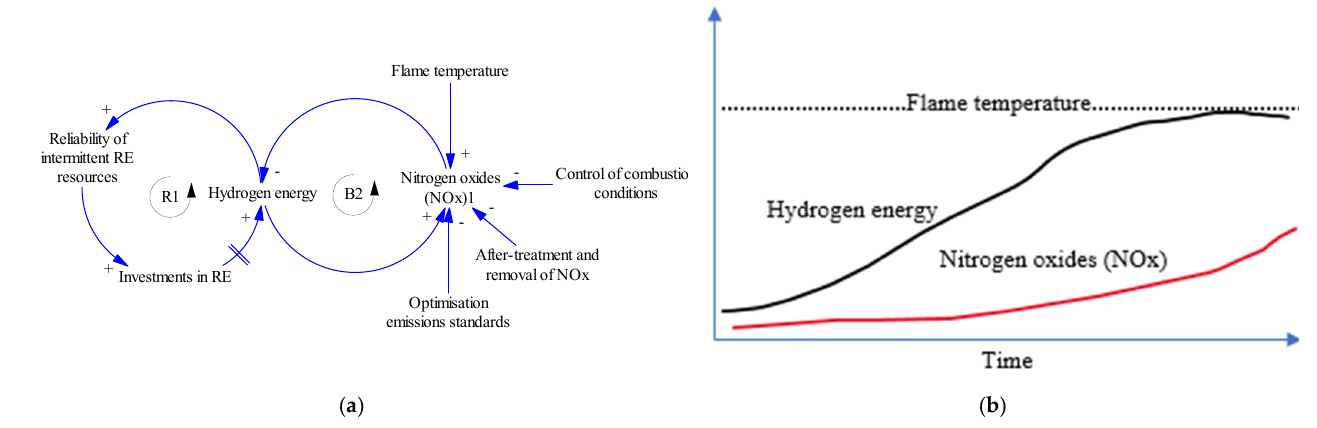
Figure 6. Structure ( a ) and behavioural graph ( b ) of the Limits to Growth.